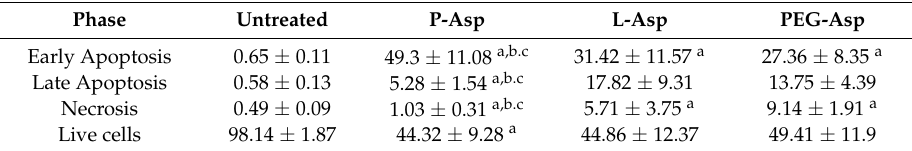
Table 2. Annexin V apoptosis detection in Jurkat cells treated with P-Asp, L-Asp and PEG-Asp at a concentration of 1 × IC 50 .